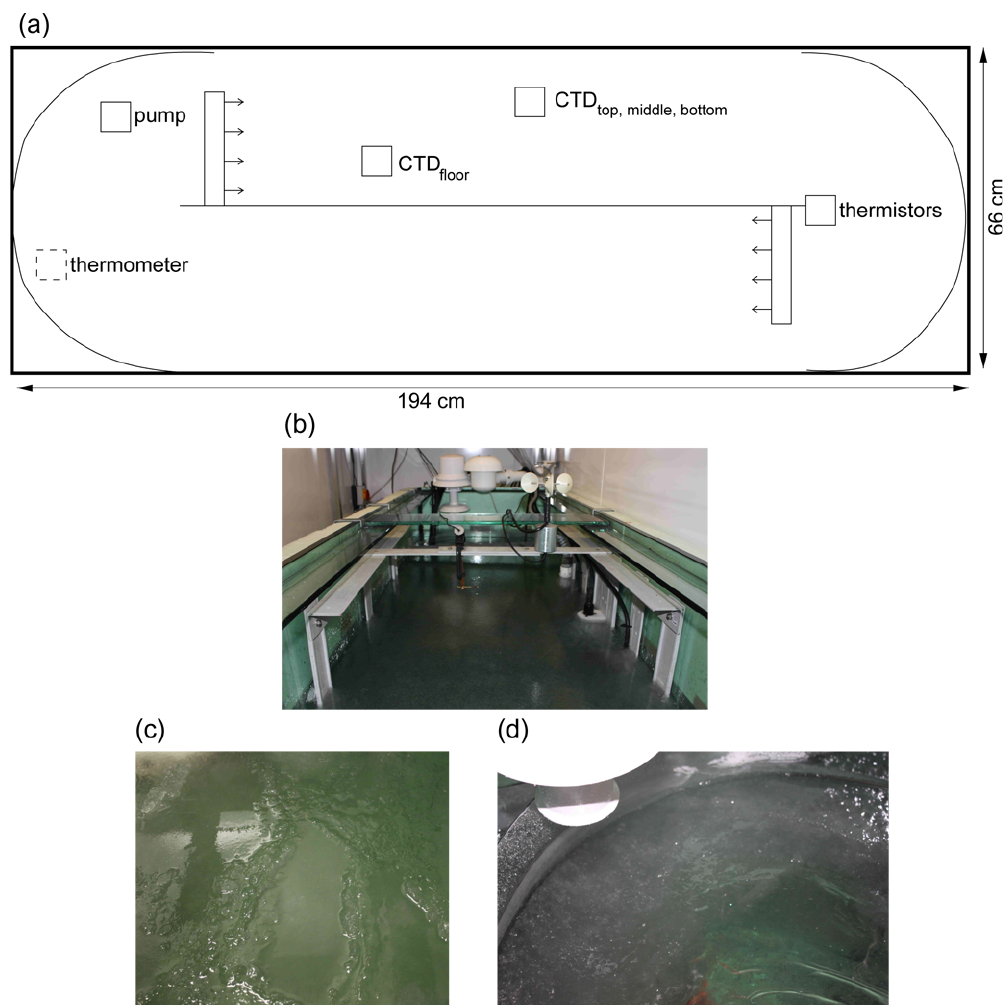
Fig. 1. (a) Sketch of the experimental setup of the tank during the experiments with current and wind. The instruments shown and the tank setup are discussed in Sect. 2. The instrumental setup in the quiescent experiments and the experiments with waves was similar. Additionally, a turbulent instrument cluster was installed during the experiments (not shown). (b) Picture of the tank during a quiescent experiment. (c) Pancake ice in an experiment with waves. (d) Grease ice accumulating in one end of the tank in an experiment with current and wind.